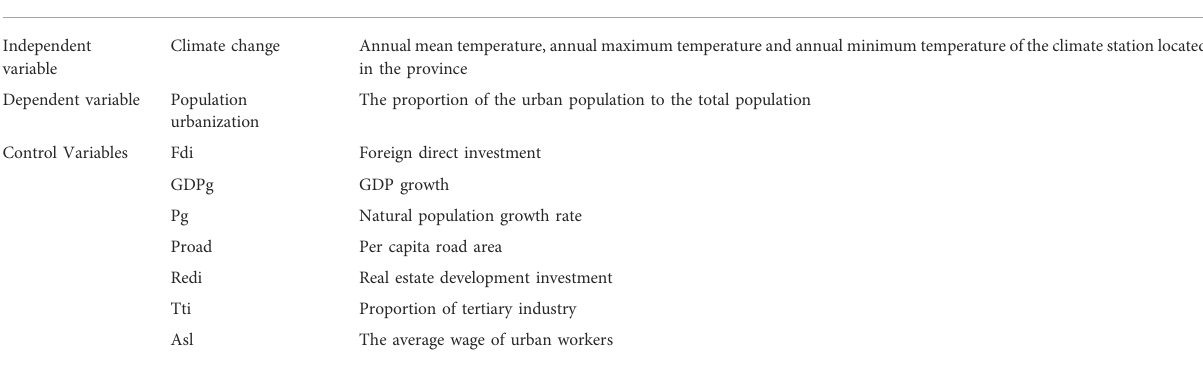
TABLE 1 Variable de fi